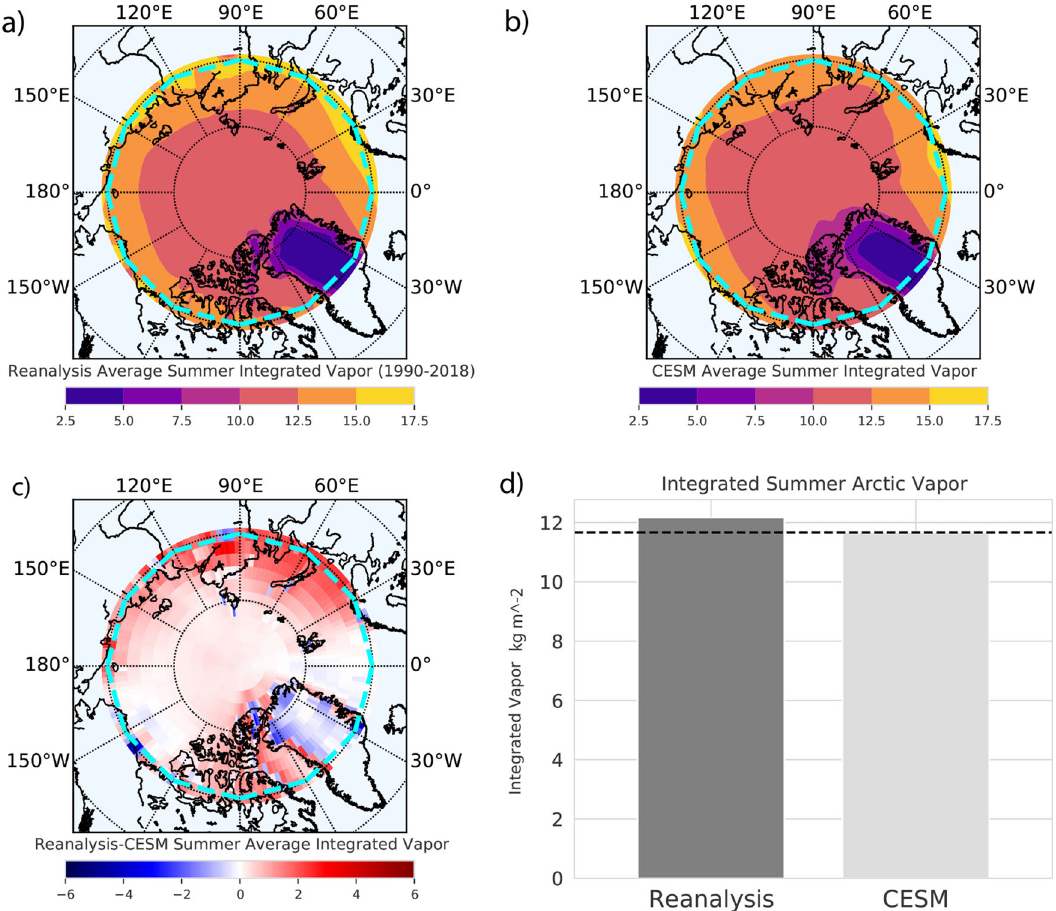
Fig. 1 Comparison of iCESM-simulated summer integrated vapor to ERA5 reanalysis data. Summer Arctic total integrated vapor from a ERA5 reanalysis data, b iCESM, and c the difference between a and b . d A comparison of the Arctic-averaged total integrated vapor from iCESM and ERA5. Units are in kg m − 2 . The cyan dashed line at 69° latitude marks the Arctic extent used in the area average in d